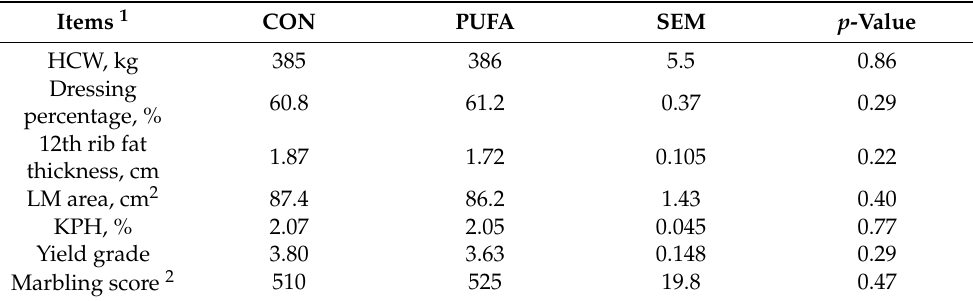
Table 5. Effects of supplementing cows with either 155 g DM/d EnerGII (CON) or 80 g DM/d Strata + 80 g DM/d Prequel (PUFA) for the last 77 ± 6 d of gestation on steer progeny carcass characteristics.